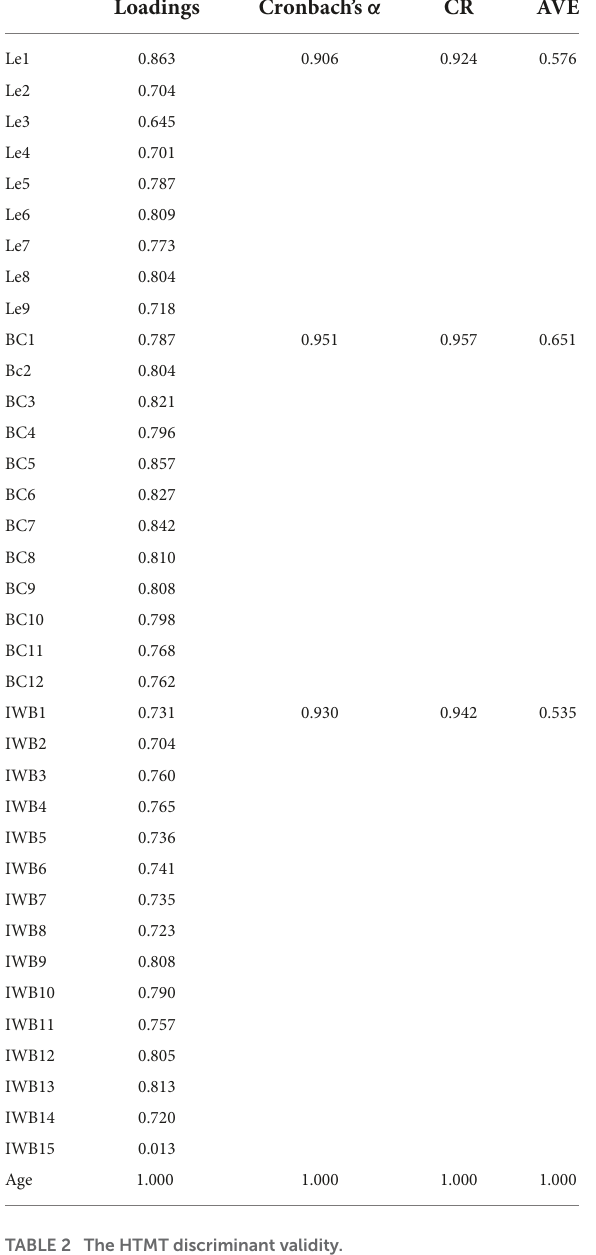
TABLE 2 The HTMT discriminant